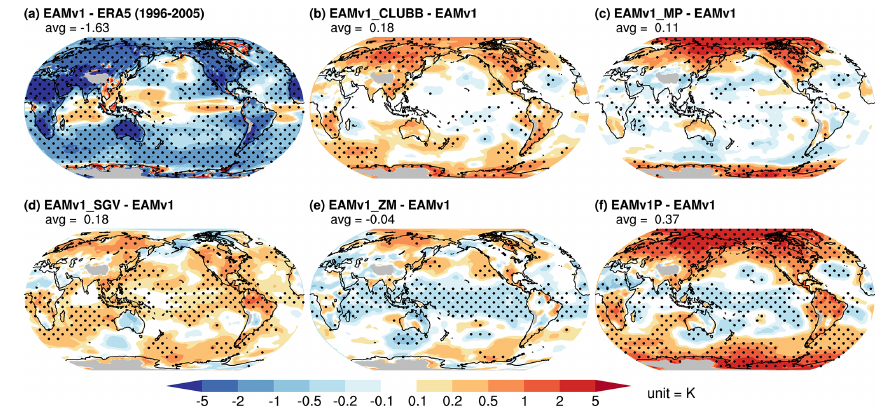
Figure 6. Estimated inversion strength (EIS; unit = K). The EIS computed from the European Centre for Medium-Range Weather Forecasts’